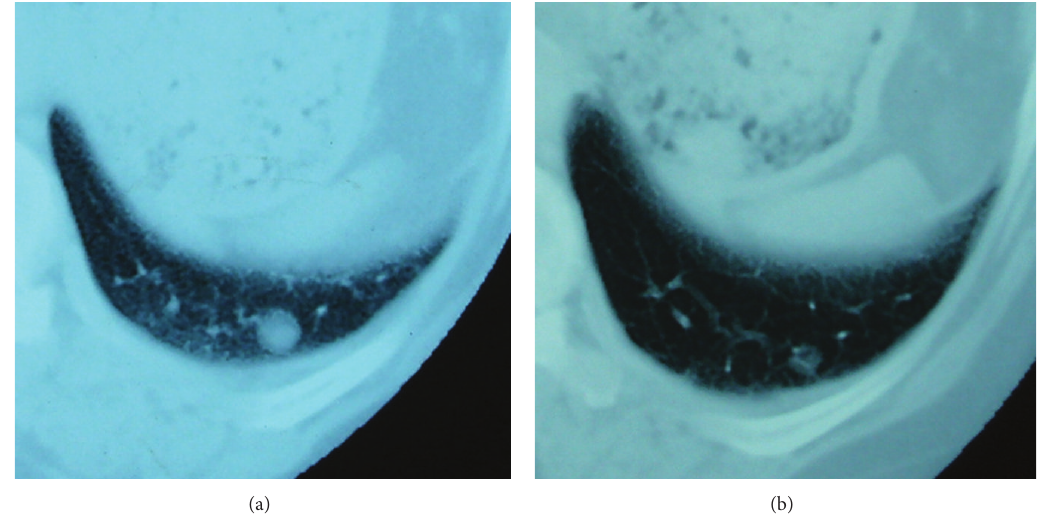
Figure 2: (a) In July 2010, a simple CT scan of the chest revealed a nodule with an irregular but well-defined margin in S10 of the left lung. (b) A chest CT scan obtained at the end of the second cycle of treatment revealed a reduction in tumor size.